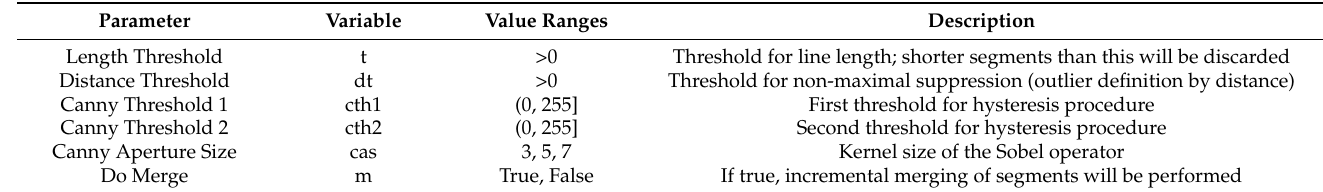
Table 1. Input parameters for the Fast Line Detector in OpenCV